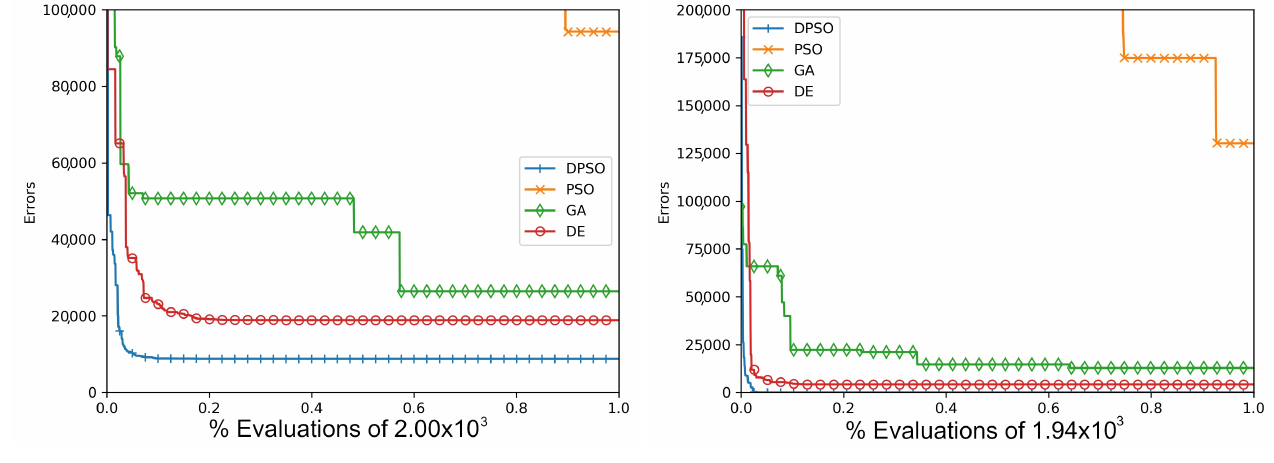
Figure A4. The average Ackley ( f 6 , f 7 , f 8 ) and Rosenbrock ( f 9 , f 10 , f 11 ) global best results over time for 7